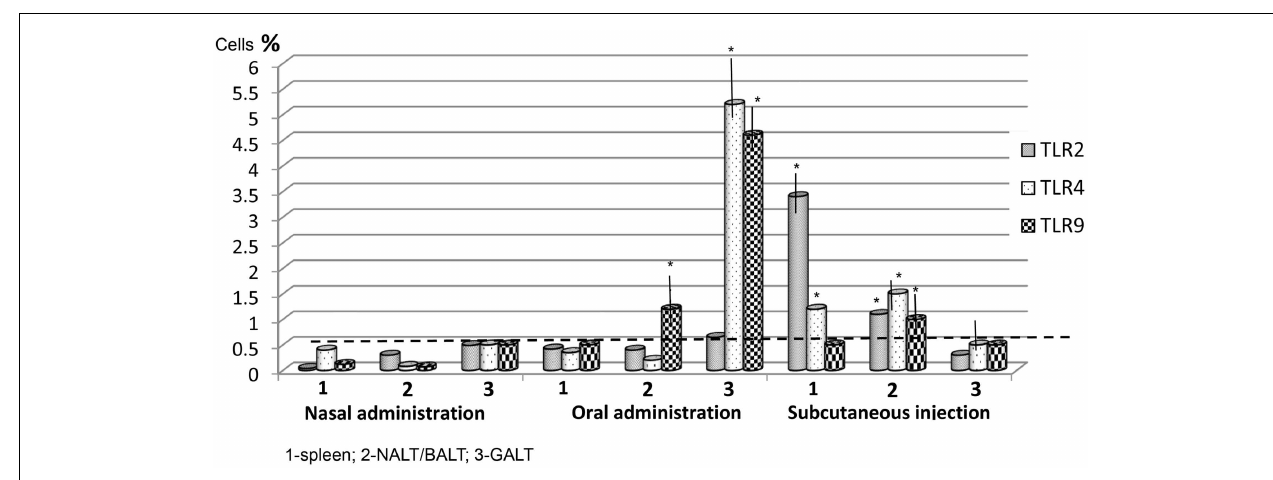
nasal/oral admin.TLR2,4 p > 0.05;TLR9 p < 0.05; nasal/subcut. admin. TLR2,3,4 p < 0.05; oral/subcut. admin.TLR2,4 p < 0.05,TLR9 p > 0.05. GALT : nasal/oral admin.TLR2 p > 0.05;TLR4,9 p < 0.001; nasal/subcut. admin.TLR2,3,4 p > 0.05; oral/subcut. admin.TLR2 p > 0.05,TLR4,9